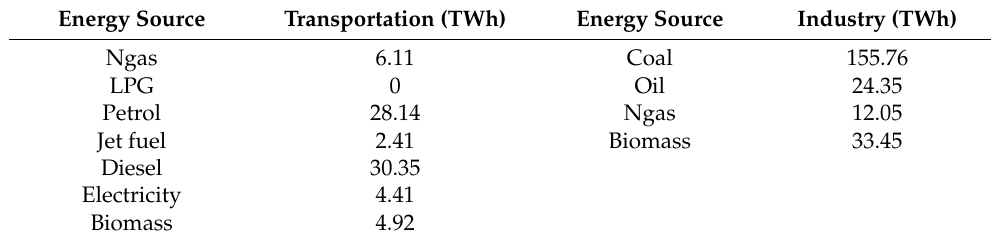
Table 2. Different sources of energy consumption in transportation and industry sectors in 2020.